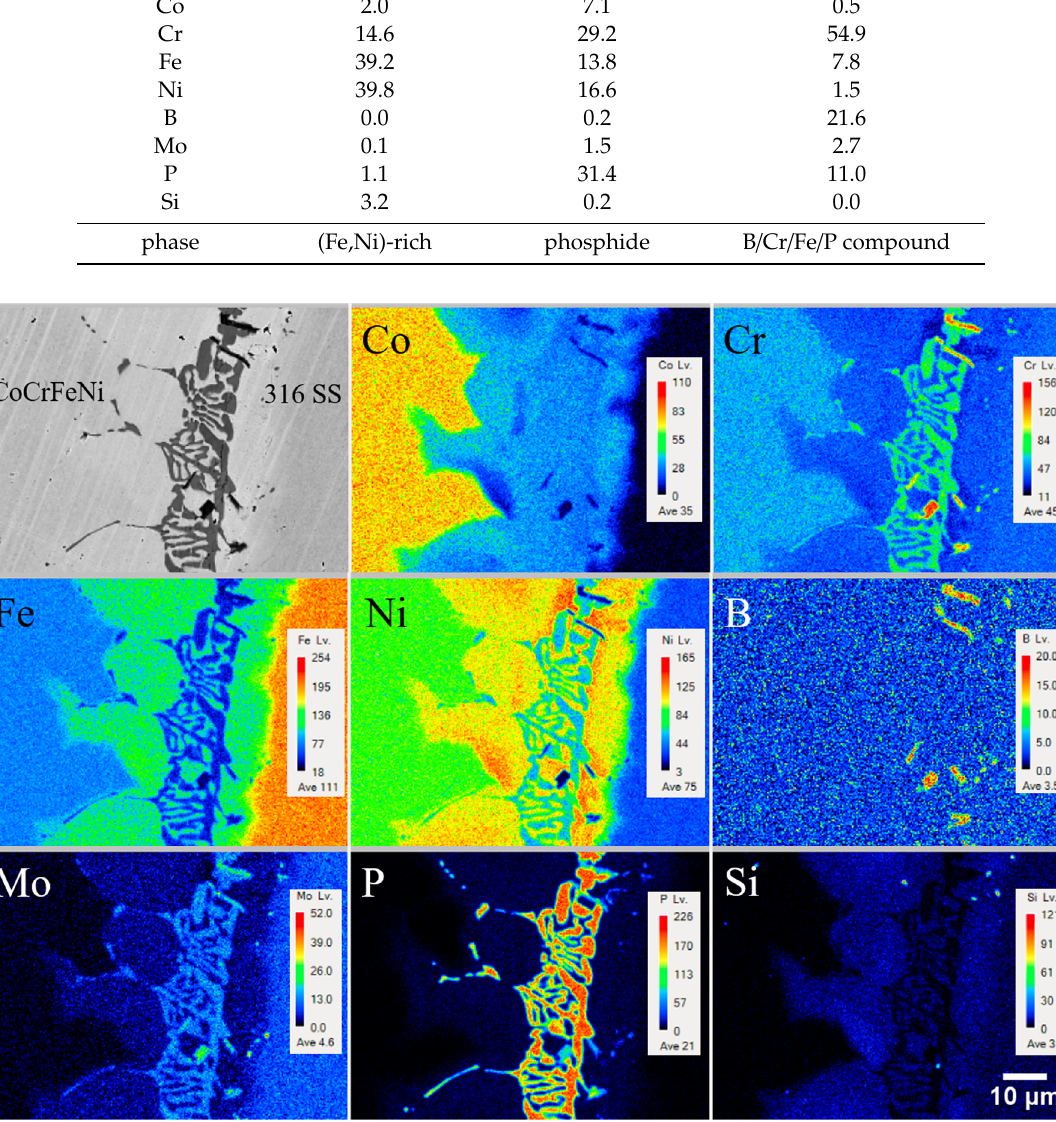
Figure 8. The BEI of CoCrFeNi/MBF601/316 joint infrared brazed at 1050 °C for 180 s and the associated elemental mappings determined by EPMA.